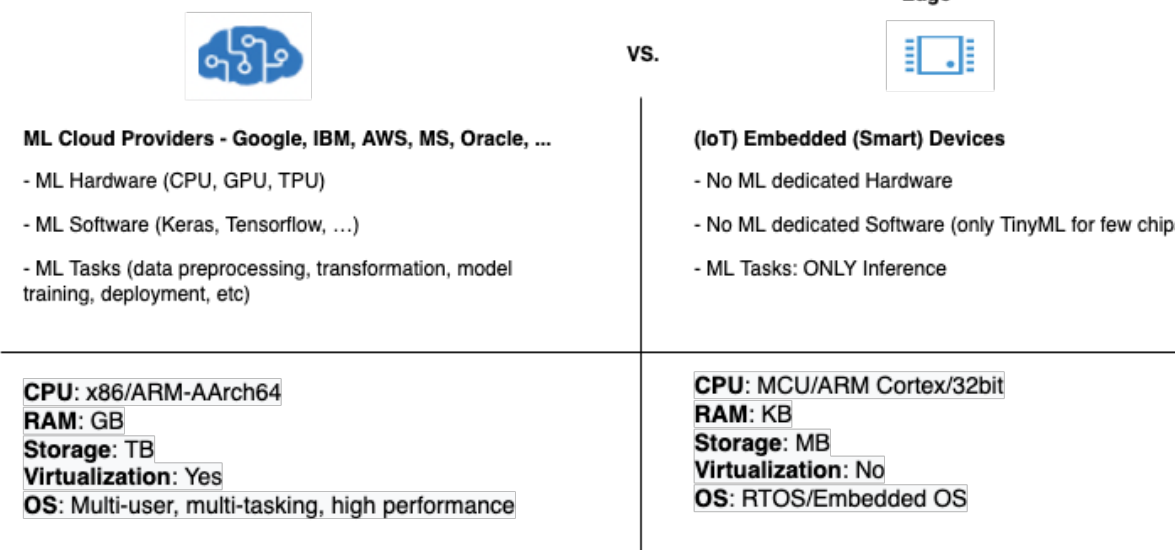
Figure 3. Edge ML in terms of Training and Inference phase.